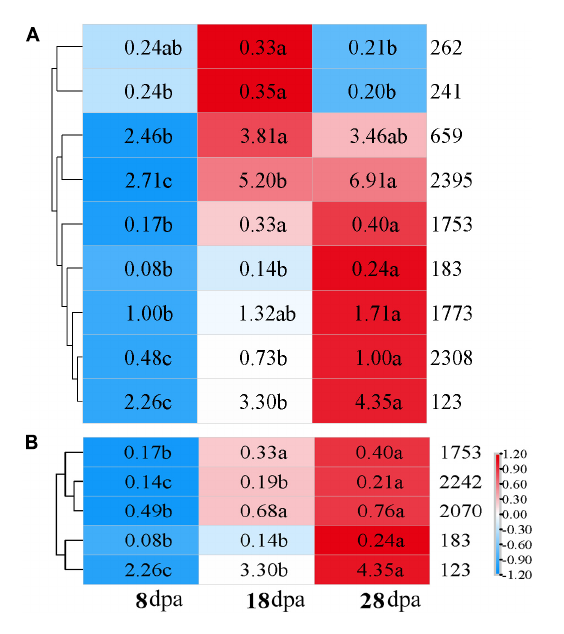
FIGURE5 Expression of key metabolites in different samples. Distribution of key identified metabolites across different samples compared with the different development stages. Values represented in the scale correspond to the relative quantitative value of metabolites. Letter indicate the significant difference of relative quantitative values of three stages. (A) 8 dpa with 18 dpa; (B) 8 dpa compared with 28 dpa. 262: choline, 241: 4-coumaric acid, 659: L-glutamic acid, 2,395: DL-alpha-tocopherol, 1,753: thiamine, 183: hydrocinnamic acid, 1,773: adenosine, 2,308: alpha-lactose, 123: salicylic acid (SA), 2,242: docosapentaenoic acid, 2,070: eicosapentaenoic